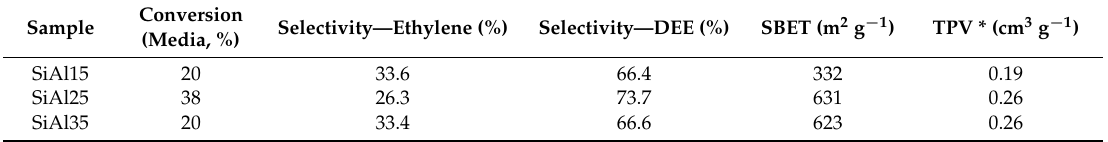
Figure 8. ( a ) Ethanol conversion as a function of time at 250 °C of the calcined [Al] HPM-1 samples and ( b ) product selectivity.